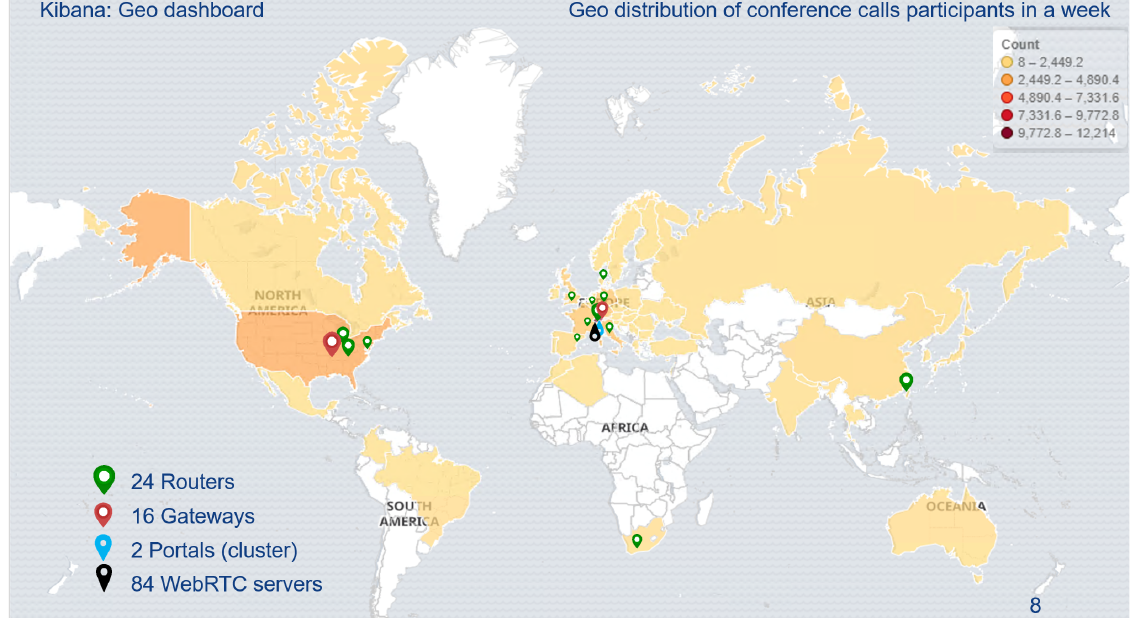
Figure 1. On premise infrastructure worldwide and geolocation of attendees using Vidyo during a week time span, mostly coming from Switzerland.